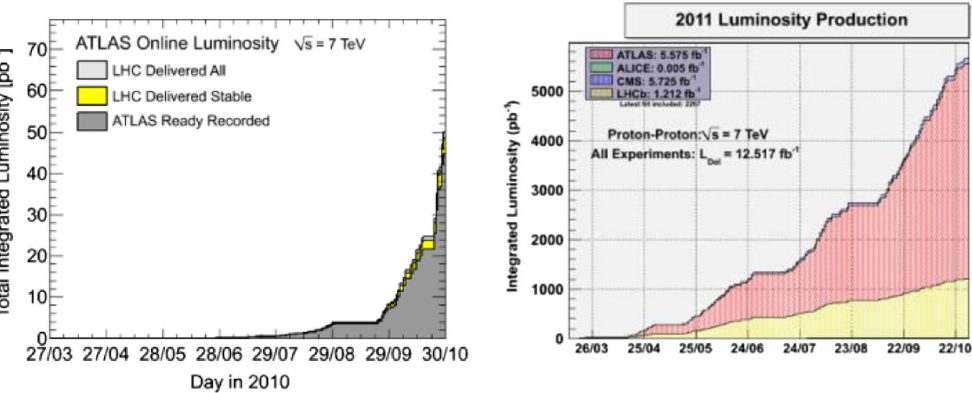
FIG. 28. Plots show the daily progress in performance of the LHC in 2010 and 2011, reaching a maximum of 44 in 2010 and 6000 in